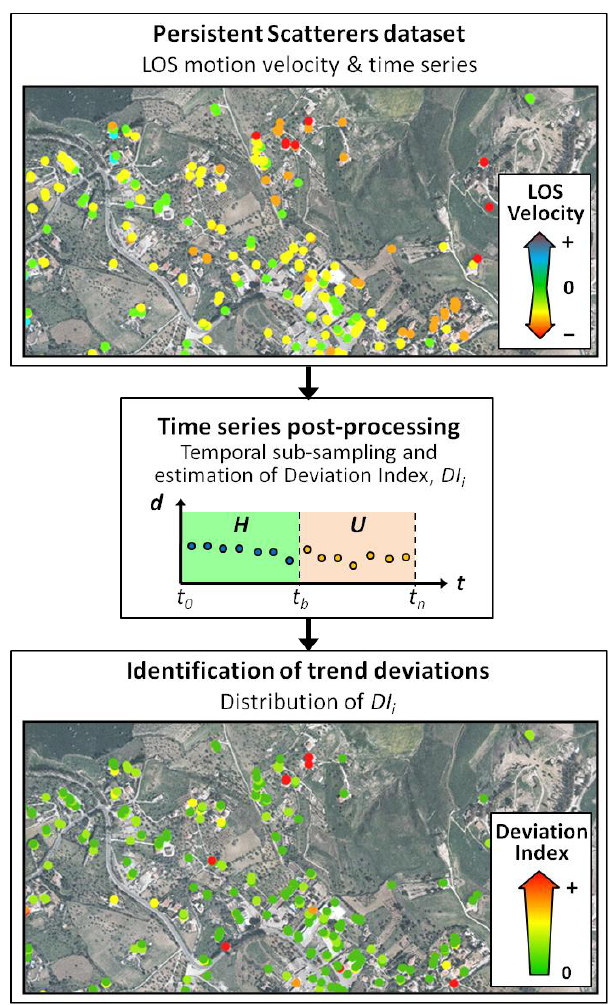
Fig. 1. Methodology employed for the identification of trend devia- tions within PS time